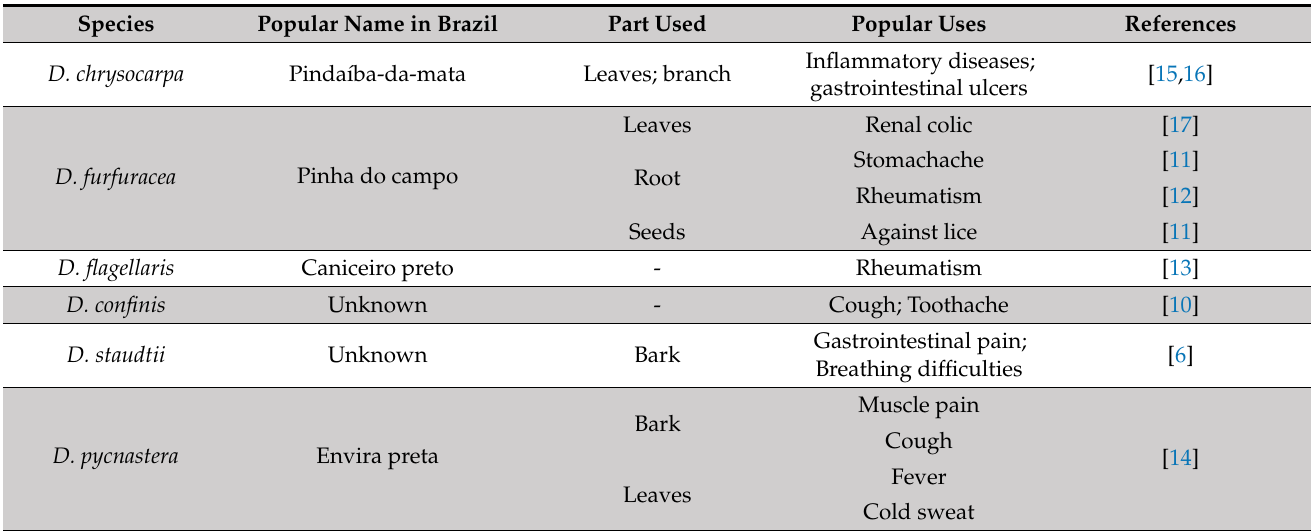
Table 1. Medicinal uses of Duguetia